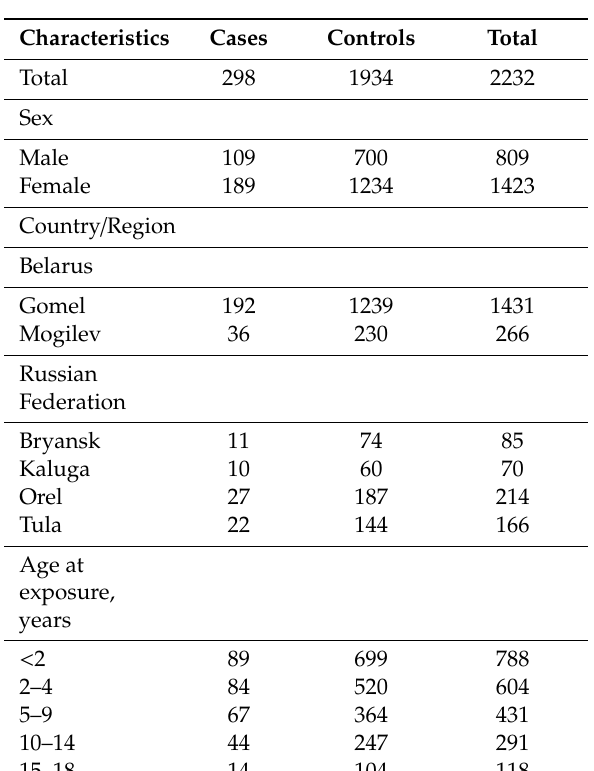
Table 1. Descriptive characteristics of study cases and controls.